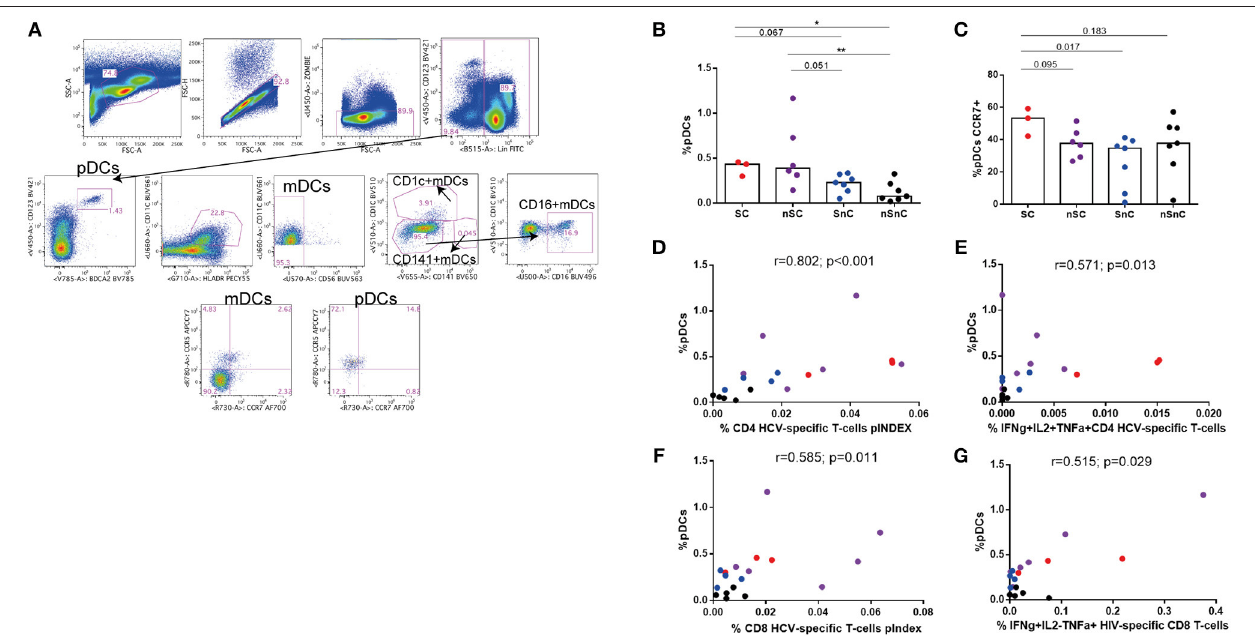
FIGURE 6 | Dendritic cells. (A) Gating strategy. (B) Plasmacytoid dendritic cells (pDCs) frequency. Mann–Whitney U -tests was used to assess diferencies between groups. (C) CCR7 expresing pDCs. Mann–Whitney U -tests was used to assess diferencies between groups. (D-G) Spearman correlations between pDCs frequency and HCV- and HIV-specific T-cell responses. SC, supercontrollers, HCV spontaneous clearers and HIV-elite controllers; nSC, non-spontaneously HCV clearers HIV-elite controllers; SnC, HCV spontaneous clearers non-HIV-elite controllers; nSnC, non-spontaneously HCV clearers non-HIV-elite controllers. Statistical values are shown as: * p = 0.05–0.01; ** p = 0.01–0.001; *** p < 0.001.